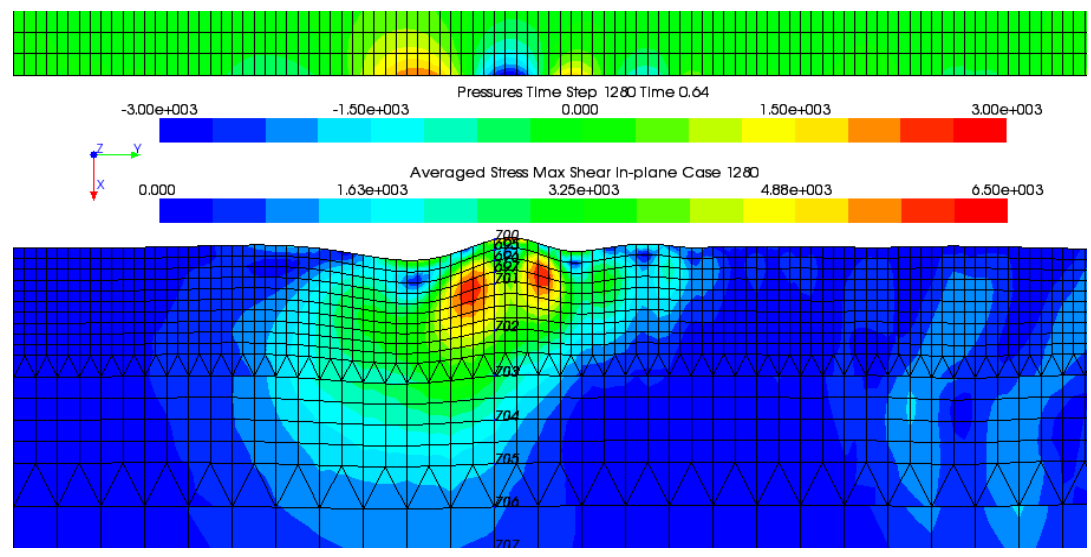
Figure 9. This enlarged view shows the shear stress magnitude, a measure of deformation.